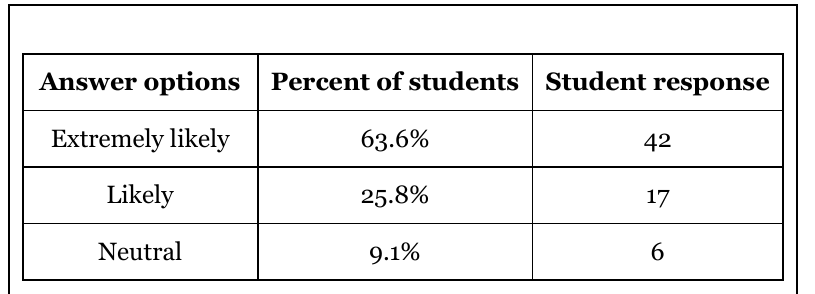
Response for Likelihood Students Would Register for a Class Using a Resource Similar to the Health Psychology OER Instead of a Traditional Textbook (n=66)